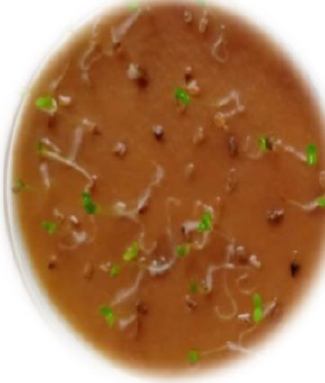
6 of 18 Table 2. Average water content for each seed type (GL: peripheral seeds; GT: central seeds) of A.P var. pyrethrum and A.P var. depressus. Samples